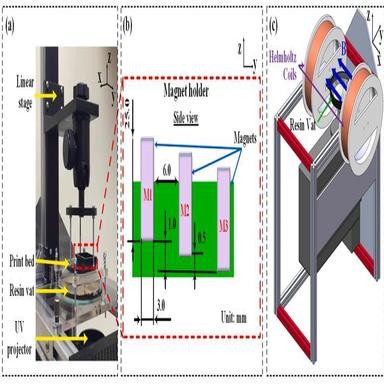
(a) Customized DLP printer setup and (b) the linear array of NdFeB magnets with vertical steps in the magnet holder to generate gradient particle distribution during the printing process; (c) adding a set of Helmholtz coil to the customized 3D printer generates a uniform magnetic field in the resin vat for additive manufacturing of tensile test samples.